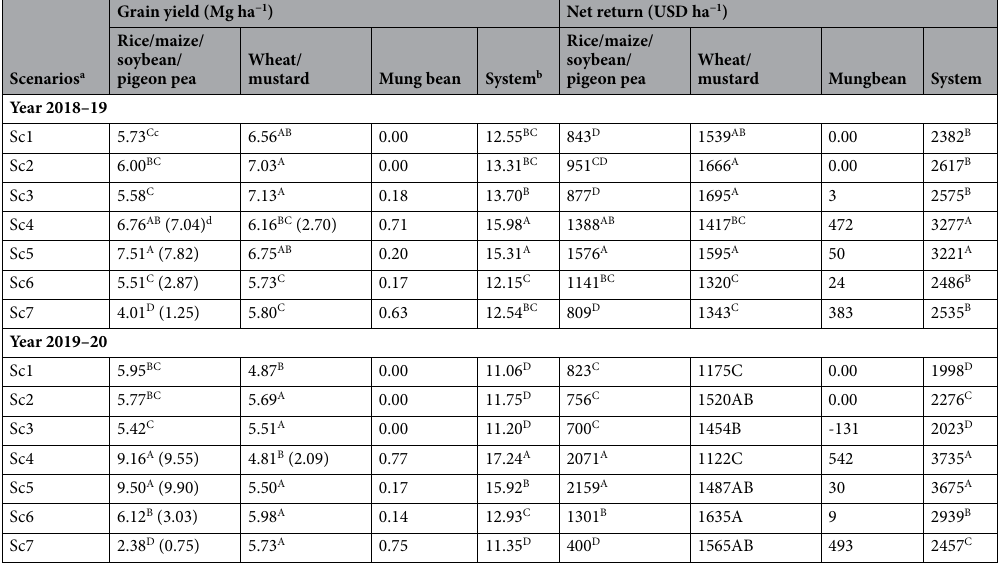
Table 1. Grain yield and net return of crops and cropping systems affected by different management practices during 2018–19 and 2019–20. a Refer Table 4 for description of scenarios. b System grain yield was expressed as rice-equivalent yield (Mg ha −1 ). c Means followed by a similar uppercase letter within a column are not significantly different at 0.05 level of probability using Tukey’s HSD test. d Values in parenthesis indicate the actual yield of